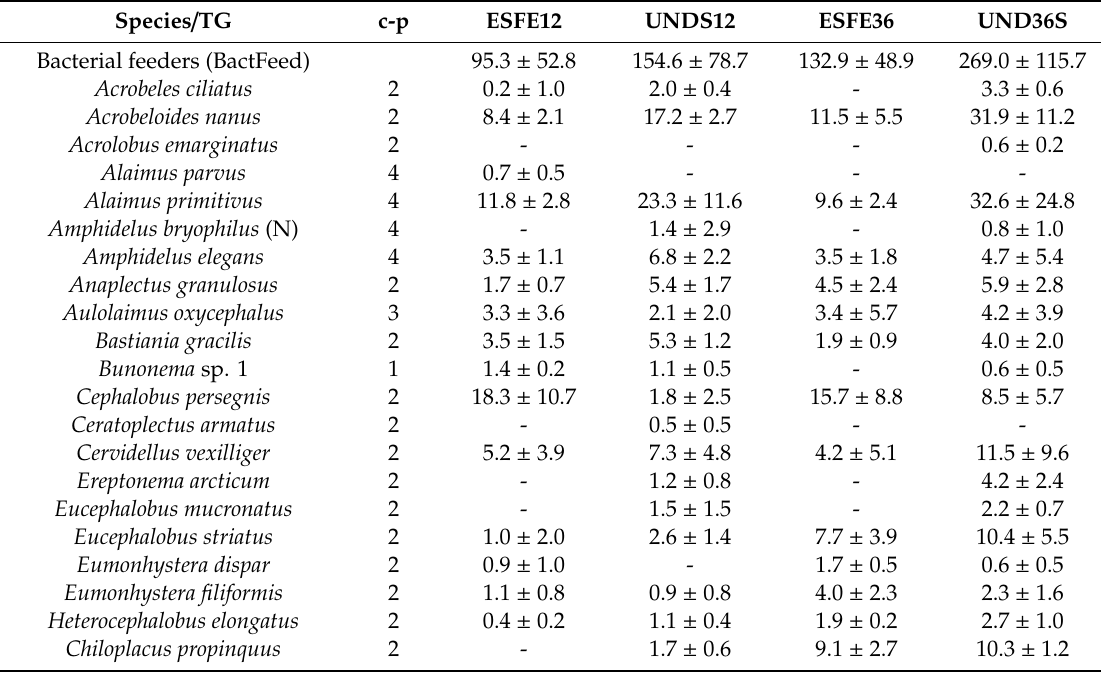
Table 3. Mean abundance of nematode species associated with early successional forest ecosystem (ESFE) and windstorm undisturbed areas (UNDS) 12 and 36 months after event. Species / TG